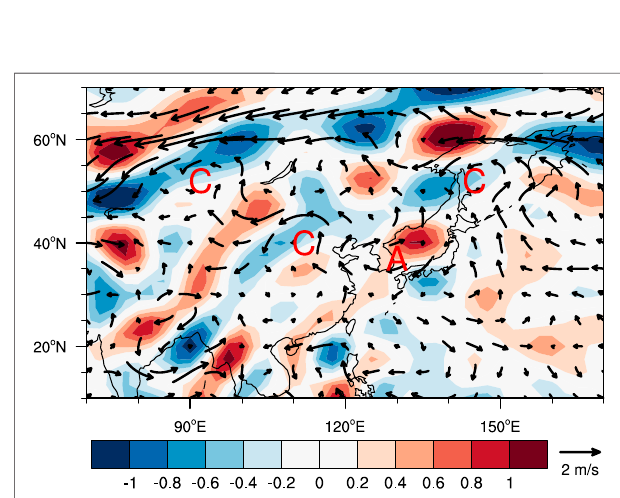
FIGURE 6 | Regression of the winter wind at 850 hPa (vector; units: m · s − 1 · K − 1 ) and divergence (shading, units: 10 − 5 s − 1 · K − 1 ) on the AMO. The letters A or C sign centre of anomalous anticyclone or cyclone,